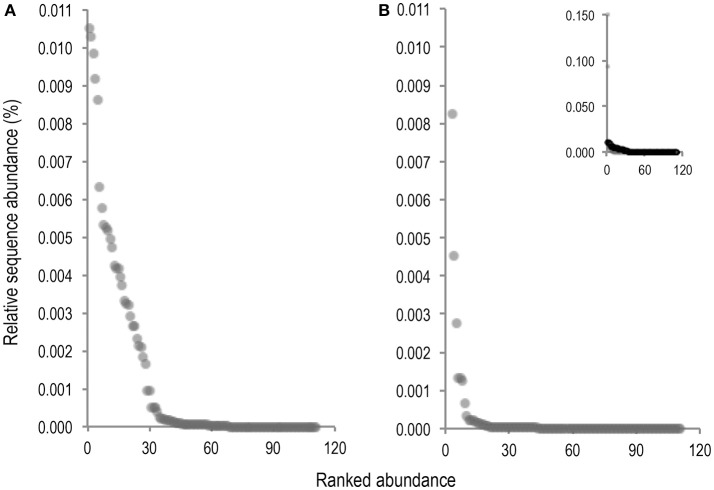
Rank abundance plots of taxa for which abundance was only measurable in either the untreated (A), or PMA-treated (B), sample condition. Ranked abundance of the untreated condition including Staphylococcus and Phenylobacterium is inset at top right corner of PMA-treated condition plot (B).